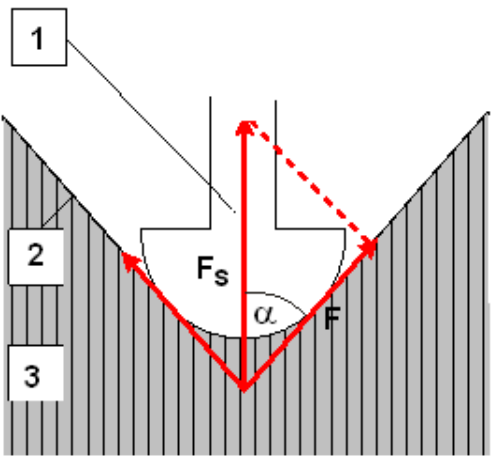
Figure 1. A simplified representation of the muscle contraction sensor (MC) measuring principle for the determination of the mechanical and physiological properties of